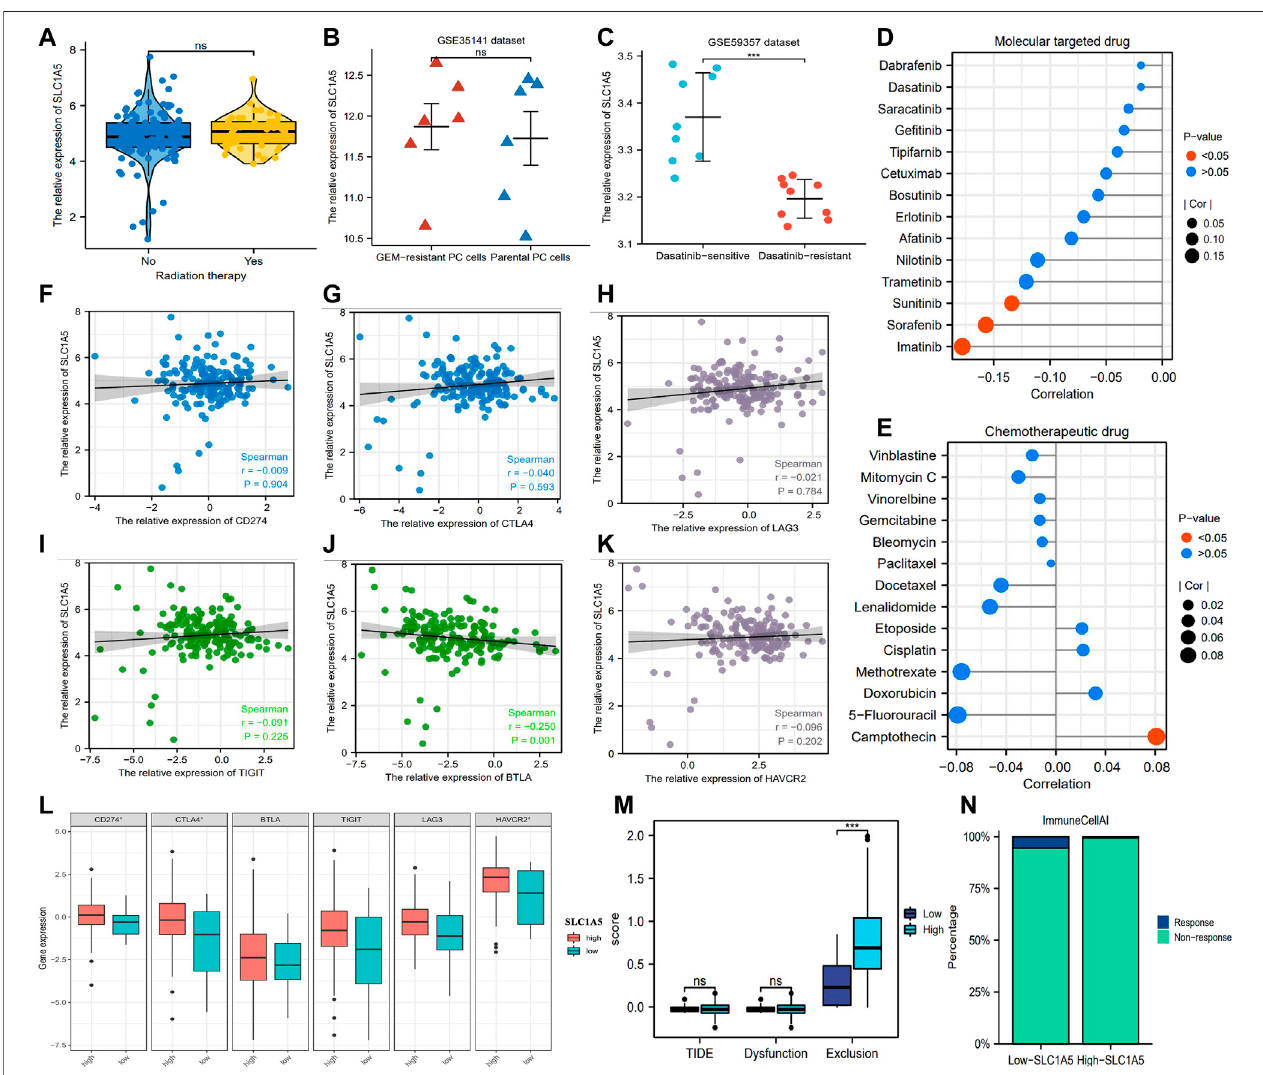
FIGURE6 | The associationsofSLC1A5with theef fi cacy ofmultiple therapeutic approaches. (A) Theexpressivedifference ofSLC1A5 between the radiotherapy- responseand-non-responsepatients. (B) TheexpressivedifferenceofSLC1A5betweengemcitabine-sensitiveand-resistantcelllines. (C) Theexpressivedifferenceof SLC1A5 between dasatinib-sensitive and -resistant cell lines. (D) The correlations between the SLC1A5 expression and the drug sensitivity of the MTT. (E) The correlations between SLC1A5 expression and the drug sensitivity of the classical chemotherapeutic agents. (F – K) The expressive correlations between SLC1A5 and sixcoreICs. (L) The expressive differences ofsixICs betweenthe high-and low-SLC1A5-expression groups. (M) Theresults ofthe TIDEimmune analyses. (N) The predictive results of “ ImmuneCellAI. ” MTT, molecular target therapy; ICs, immune checkpoints; TIDE, tumor immune dysfunction and exclusion.